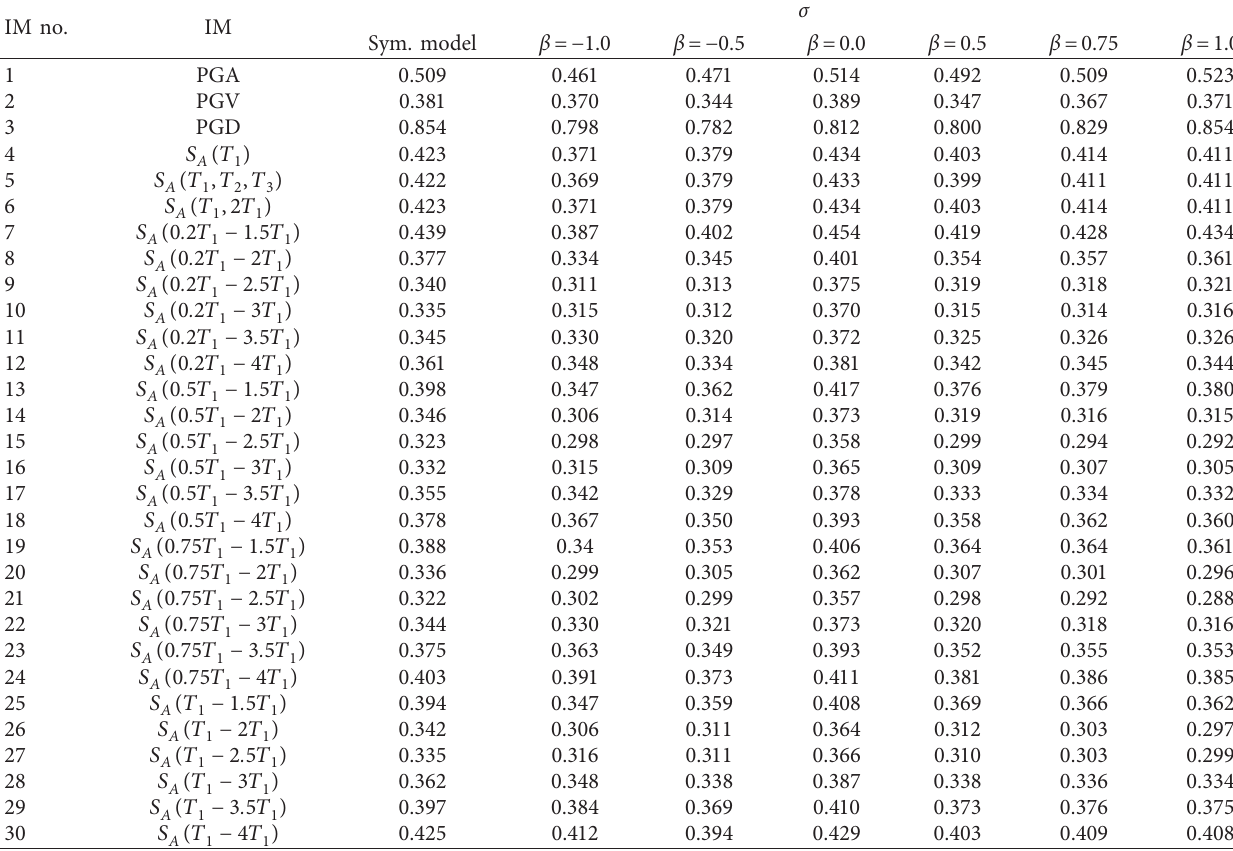
Table 6: The dispersion values ( σ ) obtained from regression analysis for all